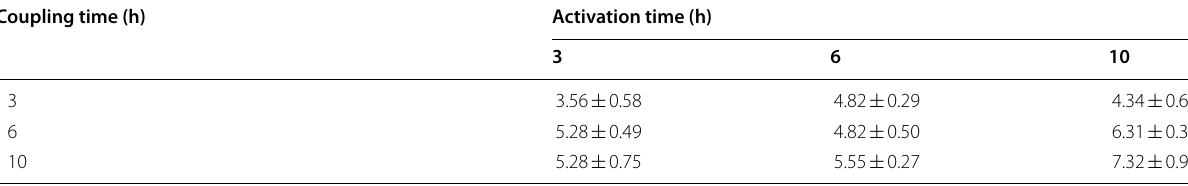
Table 2 The amounts of anti‑CD8a Ab conjugated to the PLGA‑PEG‑COOH NPs. The amounts (µg) of antibodies conjugated to 1 mg of the PLGA‑PEG‑COOH NPs when antibodies were initially added at 50 µg per 1 mg of NPs was measured by BCA assay (n mean ±